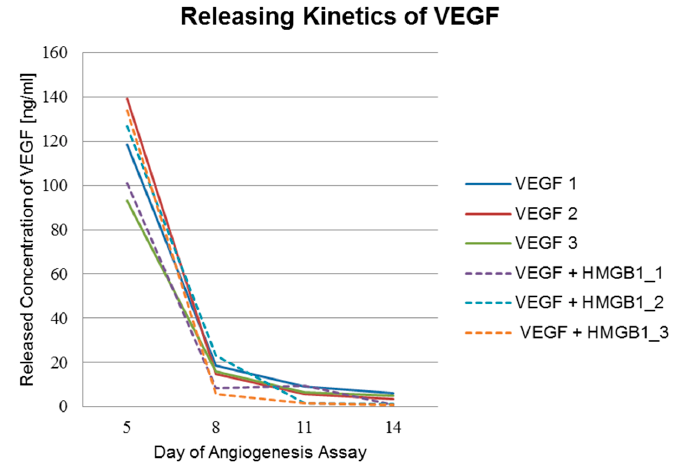
Figure 10. Released amounts of VEGF. Releasing kinetics of VEGF from titanium implants coated with PCL and functionalized with VEGF and from titanium implants coated with PCL and functionalized with VEGF and HMGB1 (dashed lines).